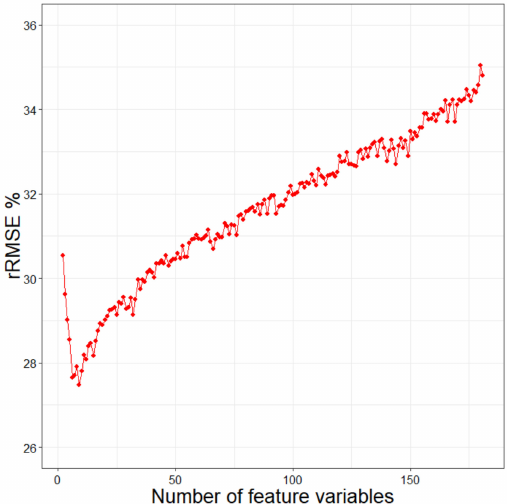
Figure 9. The change trend of rRMSE under the stepwise random forest